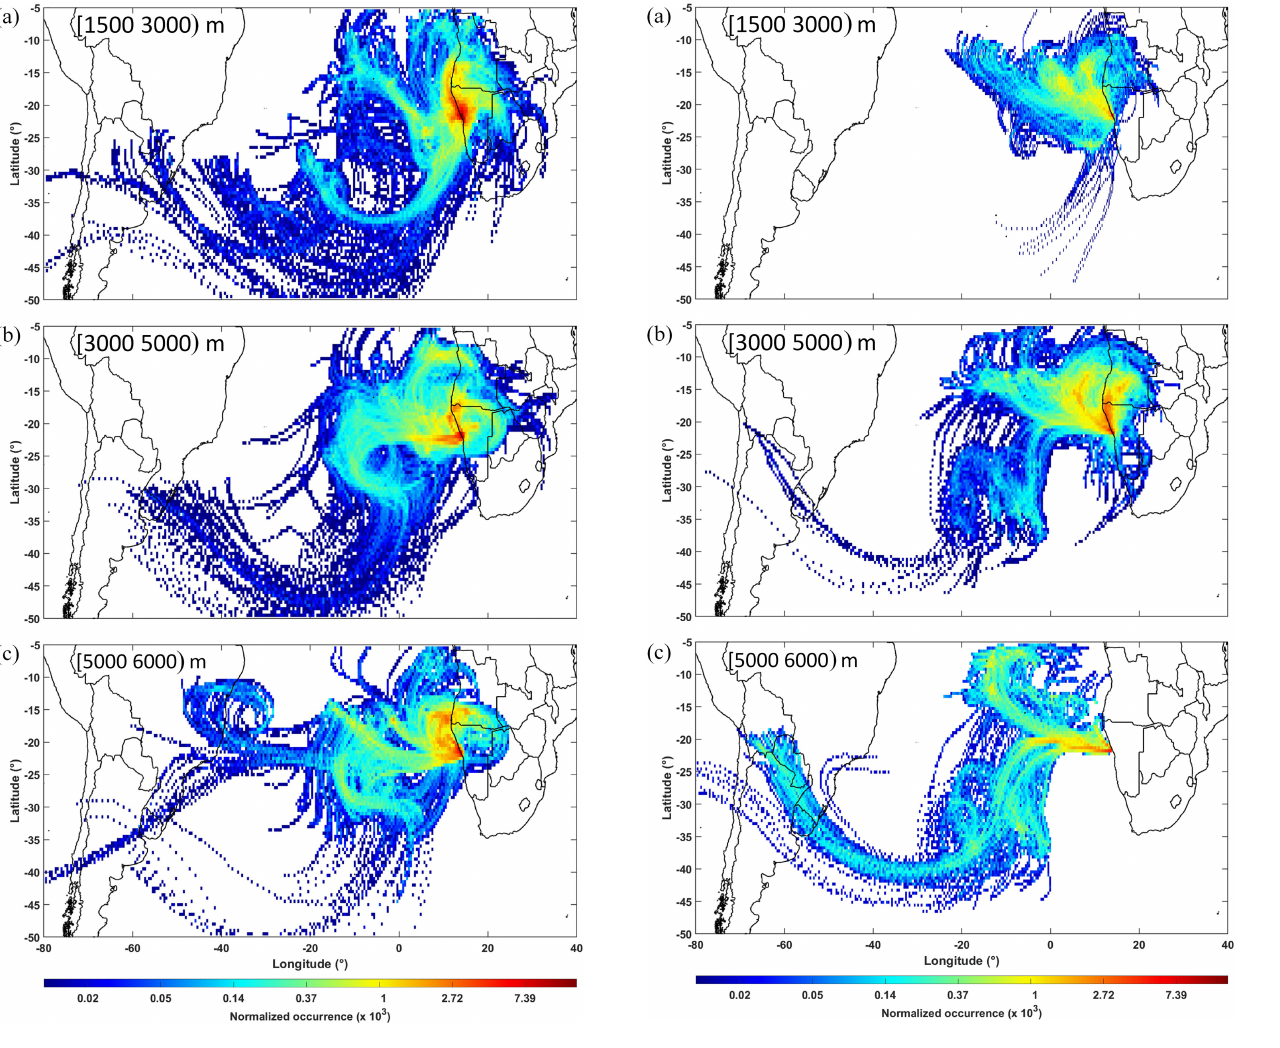
Figure 13. Normalized occurrence of the back trajectories start- ing over Henties Bay at 12:00UTC during period P 1 from the altitude ranges of [1500 3000[ (a) [3000 5000[ (b) and [5000 6000[ma.m.s.l. (c) . The calculations have been made using 6d isentropic back trajectories with the HYSPLIT model (courtesy of NOAA Air Resources Laboratory; http://www.arl.noaa.gov, last ac- cess: 23 November 2019) in ensemble mode. The normalization is performed with respect to the total number of pixels for a horizontal resolution of 0.5 ◦ .